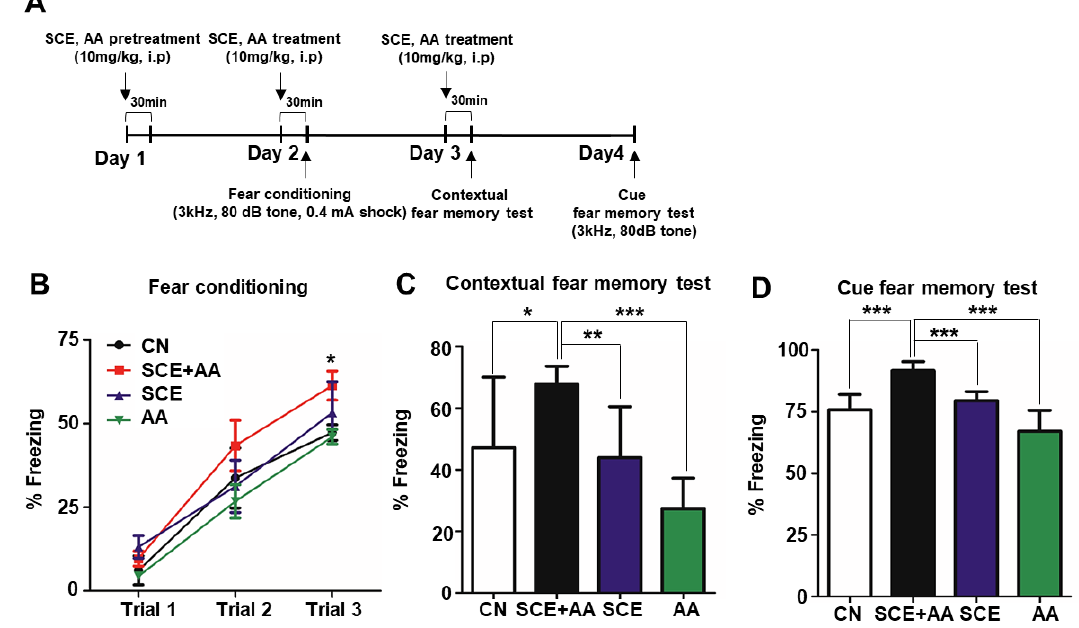
Figure 2. SCE-AA mixture enhances learning and memory. ( A ), Experimental time-line for the fear-memory test. ( B ), Fear-conditioning test in mice treated three times at 24-h intervals with SCE, AA, or an SCE and AA mixture (10 mg / kg). Mice injected with a mixture of SCE and AA showed greater freezing behavior than other groups in trial 3. Freezing time, presented as a percentage of total test time, increased linearly with trial number. ( C , D ), Contextual fear memory ( C ) and cued fear memory ( D ) test results, presented as means ± SD ( n = 5 / group; * p < 0.05, *** p < 0.001 vs. corresponding